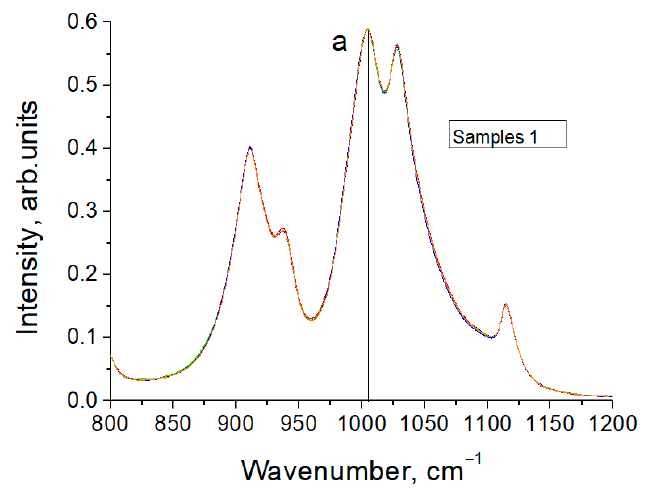
Figure 1. Regions of the spectra of five independently prepared samples of dry kaolinite. The spectra are normalized so that their intensities coincide at point “a” with a wavenumber of 1005 cm − 1 .